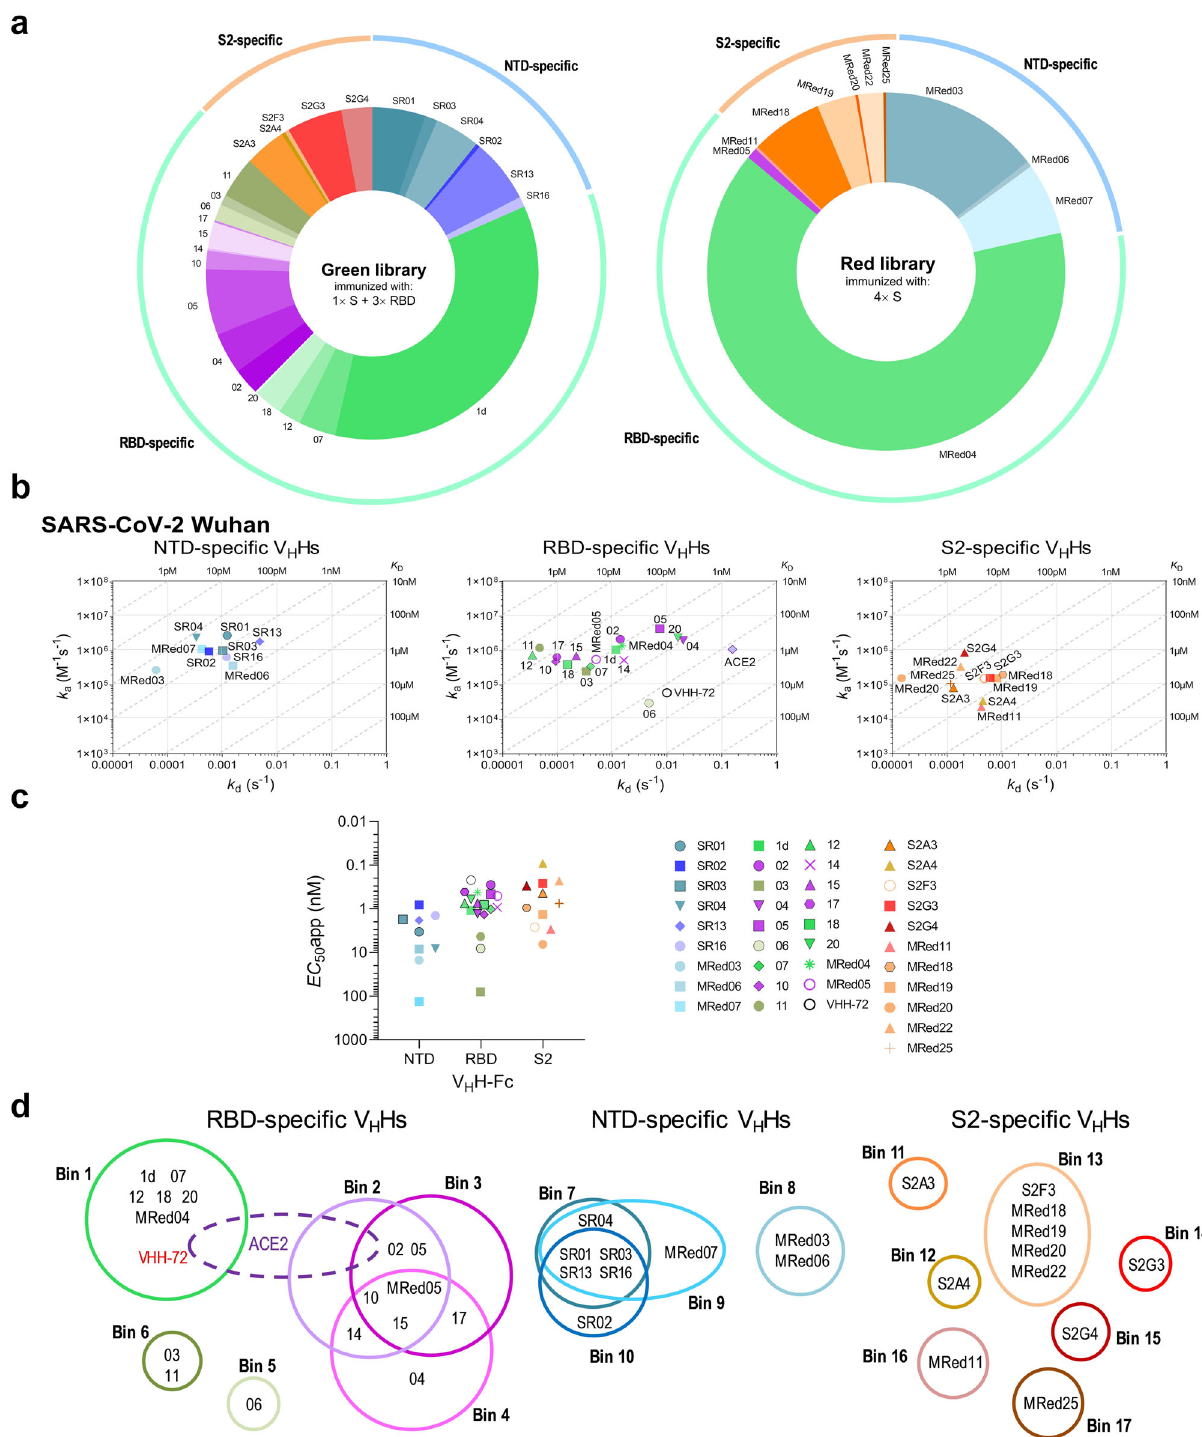
(Fig. 1d and Table 1). The benchmark VHH-72 binned with RBD-speci fi c V H Hs 1d, 07, 12, 18, 20 and MRed04. With the exception of V H H 04, all remaining bin 1, 2, 3, and 4 V H Hs (13 in total), as well as VHH-72, binned with ACE2, consistent with them being potent neutralizers (see below). V H Hs were examined for cross-reactivity to a collection of spike glycoprotein fragments from various coronavirus genera and SARS-CoV-2 variants by ELISA and SPR. In ELISA (Fig. 2a and Table 1), many V H H-Fcs cross-reacted with the S protein from VoCs Alpha, Beta, Gamma, Delta, Omicron (B.1.1.529),